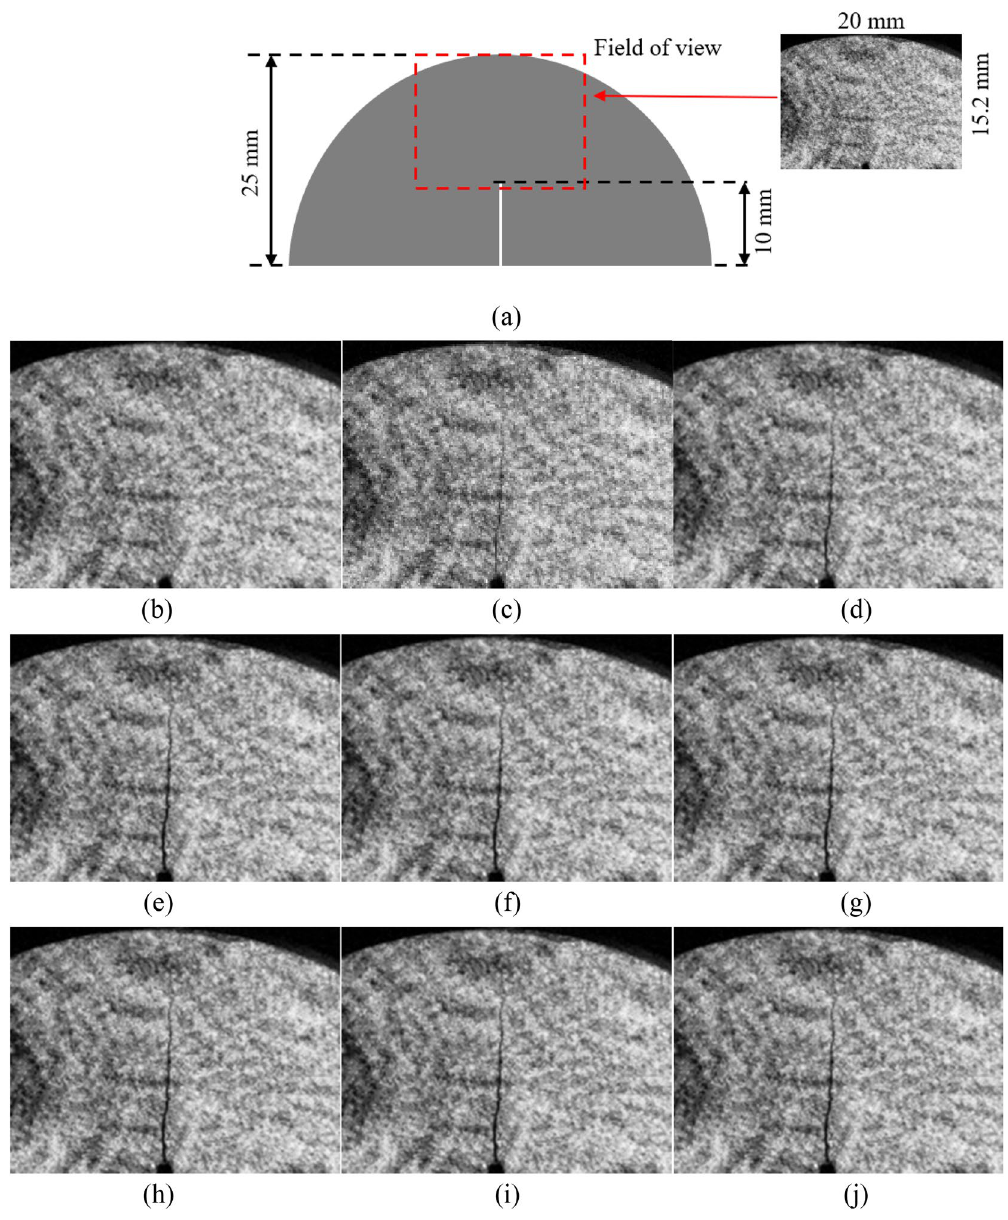
Figure 7. Crack propagation process of # 1 tuff specimen recorded in 20 μs